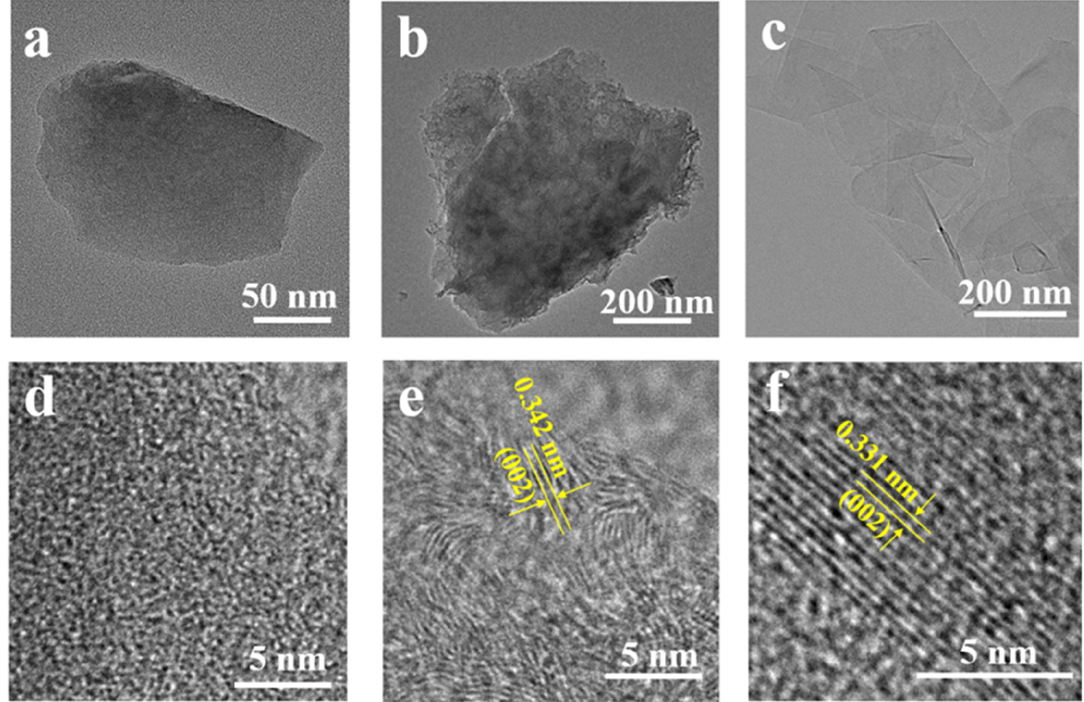
Figure 6. TEM and HRTEM micrographs of lignite samples at different temperatures of 2 GPa: ( a , d ) 20 °C, ( b , e ) 700 °C, and ( c , f ) 1300 °C.